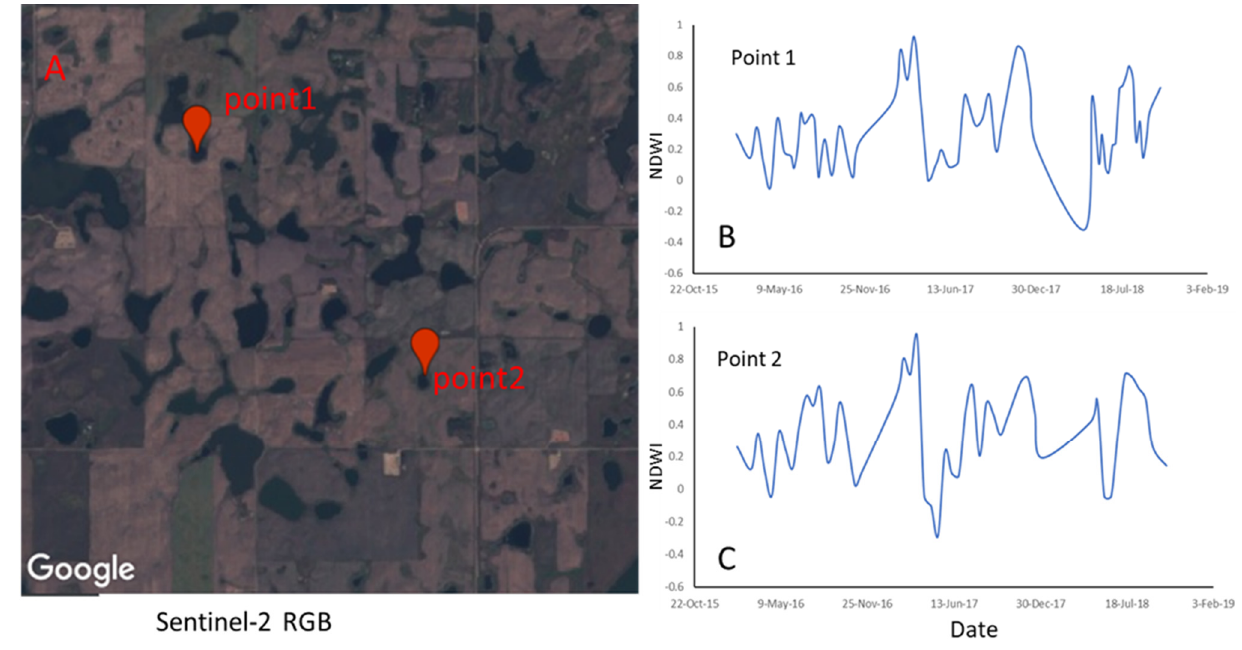
Figure 4. An RGB image of Sentinel-2 over a portion of the study area ( A ). NDWI time series in two small potholes in the study area ( B ), and showing significant temporal variations in surface water ( C ).